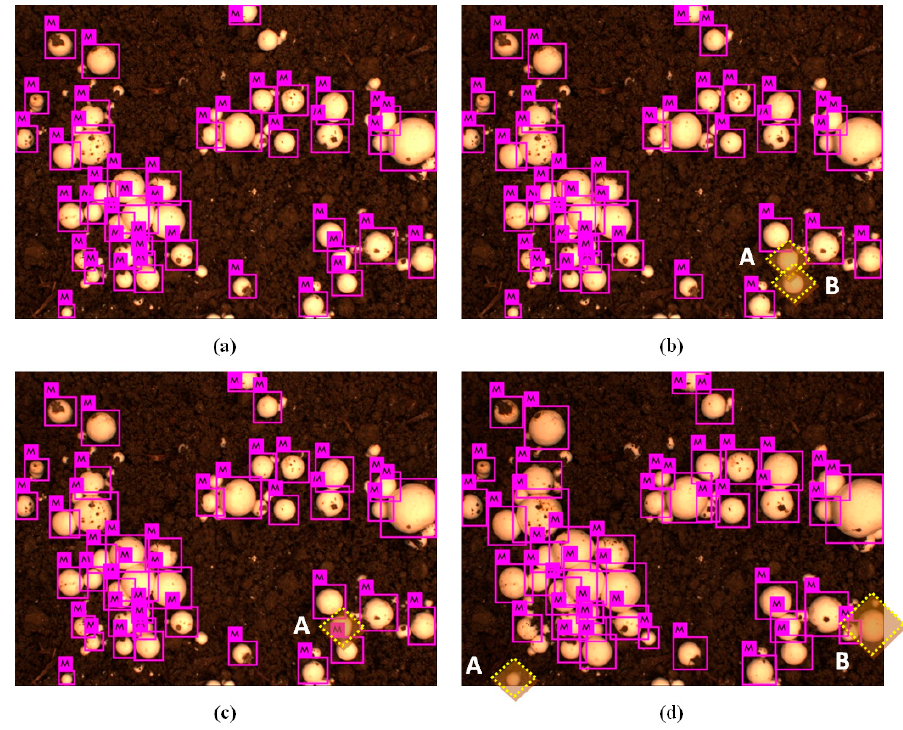
Figure 5. Positioning results of mushrooms at different times: ( a ) O t , ( b ) O t + ∆ t , ( c ) O t + 2 ∆ t , and ( d ) O t + 13 ∆ t .